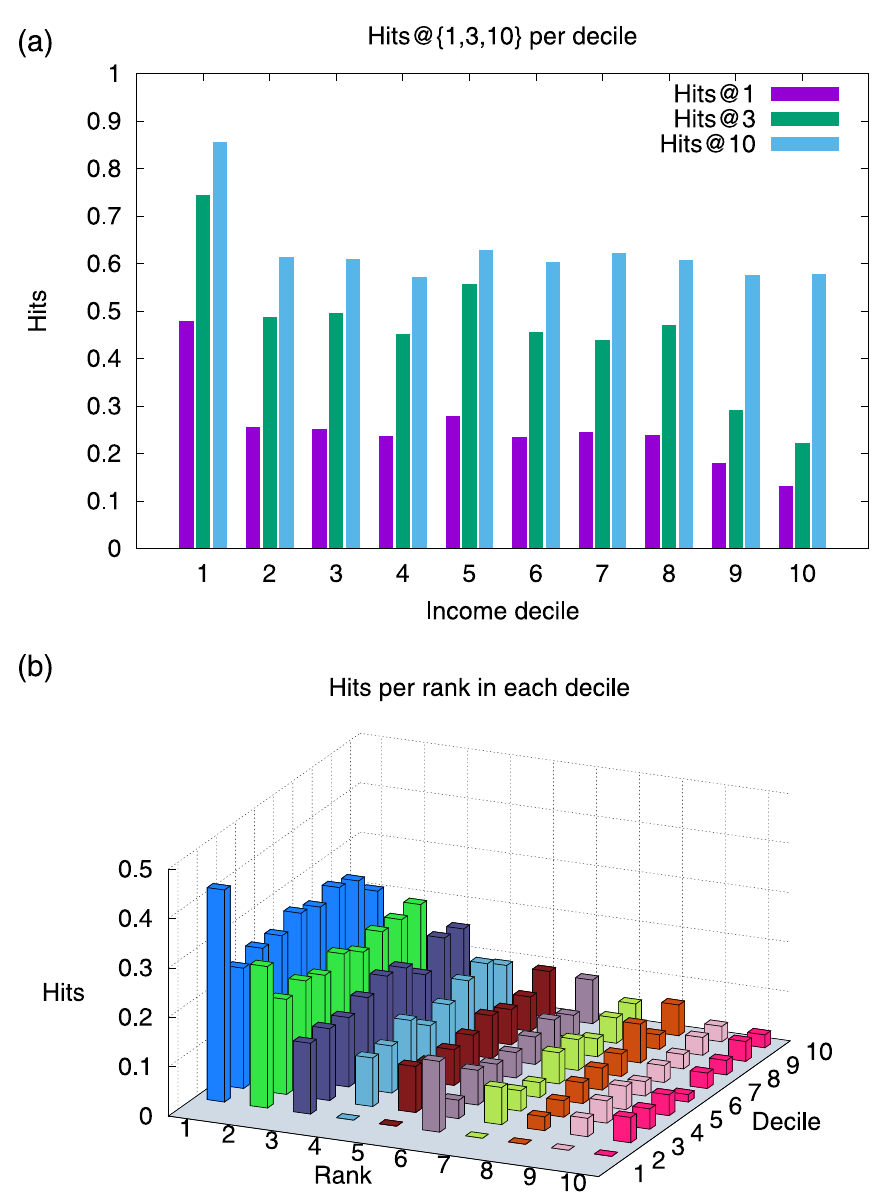
Fig 5. TuckER manages to rank high many grounding triplets, which allows the model to perform well on hits @1, @3, and @10; a) While the results in hits@1 show a better performance in the lower deciles, in hits@10, the results are more even; b) When disaggregating the results in absolute hits per rank position, we see that TuckER does not have significant differences between deciles, placing the vast majority of hits in the first five positions of each